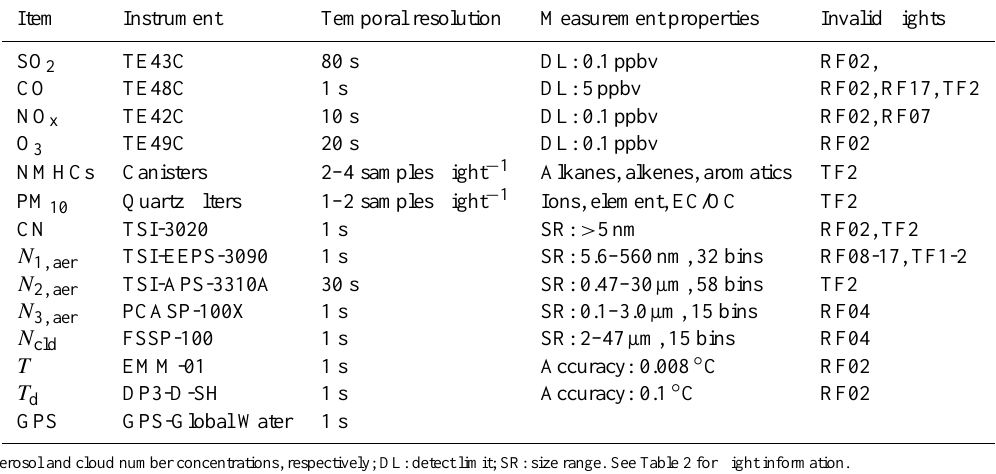
Table 1. Overview of the aircraft measurements made during IPAC-NC.